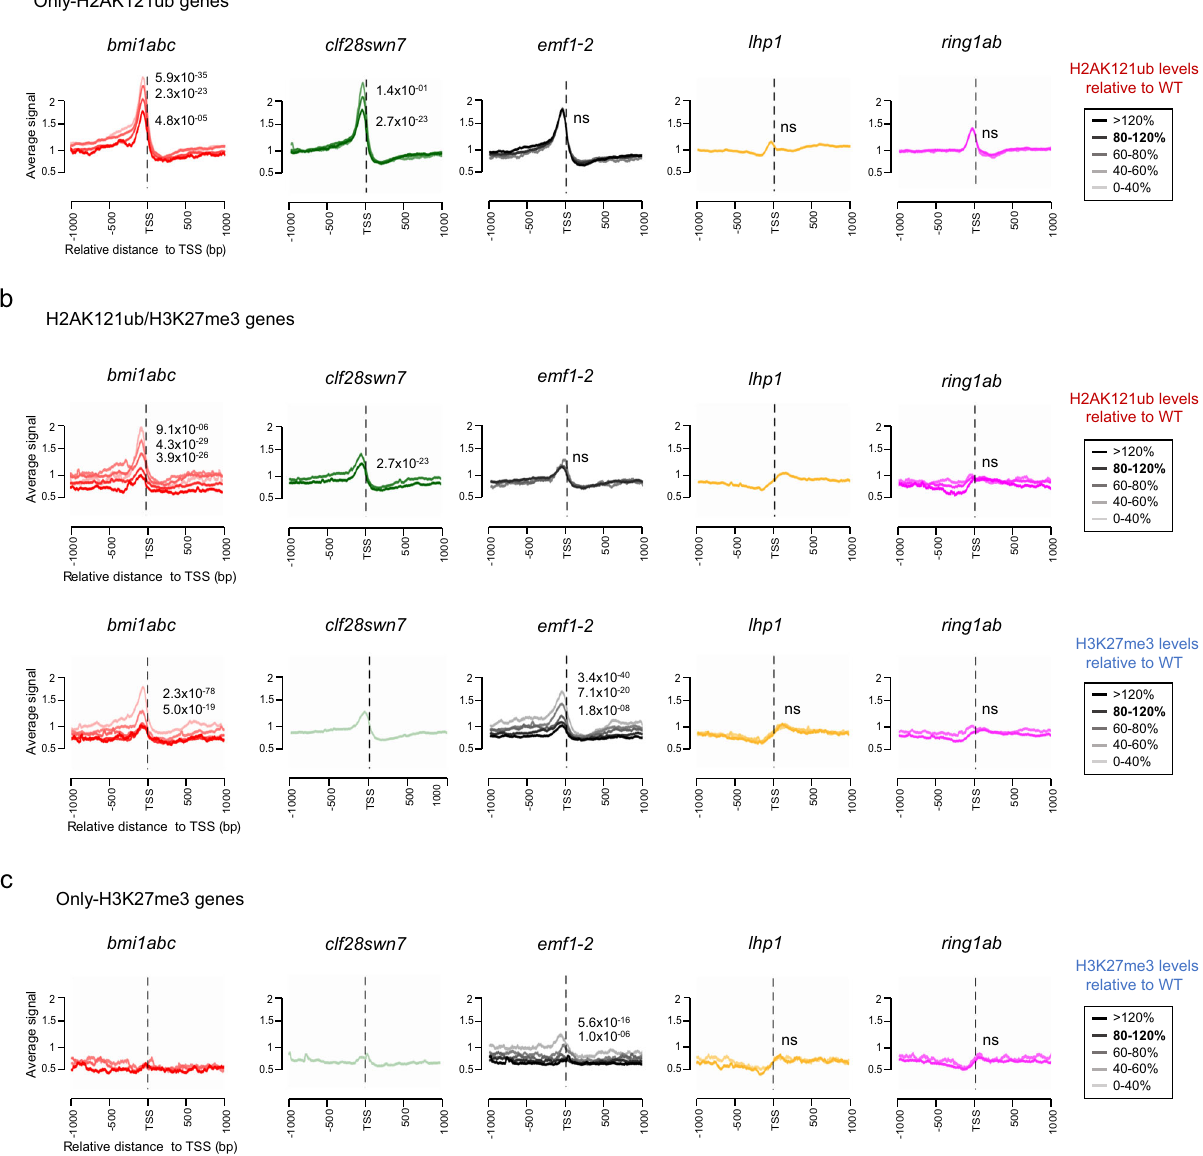
Fig. 4 PRC1-mediated H2AK121ub and EMF1 in collaboration with PRC2 activity are required to reduce chromatin accessibility. a Accessibility pro fi les around the TSS of only-H2AK121ub-marked genes in the different mutants. Genes were classi fi ed into different groups depending on their levels of H2AK121ub marks relative to WT. The prolife of the different groups is indicated in a color increasing palette form lowest to highest H2AK121ub levels. b Accessibility pro fi les around the TSS of H2AK121ub/H3K27me3-marked genes in the different mutants, grouping the genes according to their levels of H2AK121ub marks (upper panels) or H3K27me3 (bottom panels) relative to WT. The prolife of the different gene groups is indicated in a color increasing palette form lowest to highest relative H2AK121ub or H3K27me3 levels. c Accessibility pro fi les around the TSS of only-H3K27me3-marked genes in the different mutants, grouping the genes according to their levels of H3K27me3 marks relative to WT. The prolife of the different gene groups is indicated in a color increasing palette form lowest to highest relative H3K27me3 levels. Gene groups with a very small number of genes were excluded as they